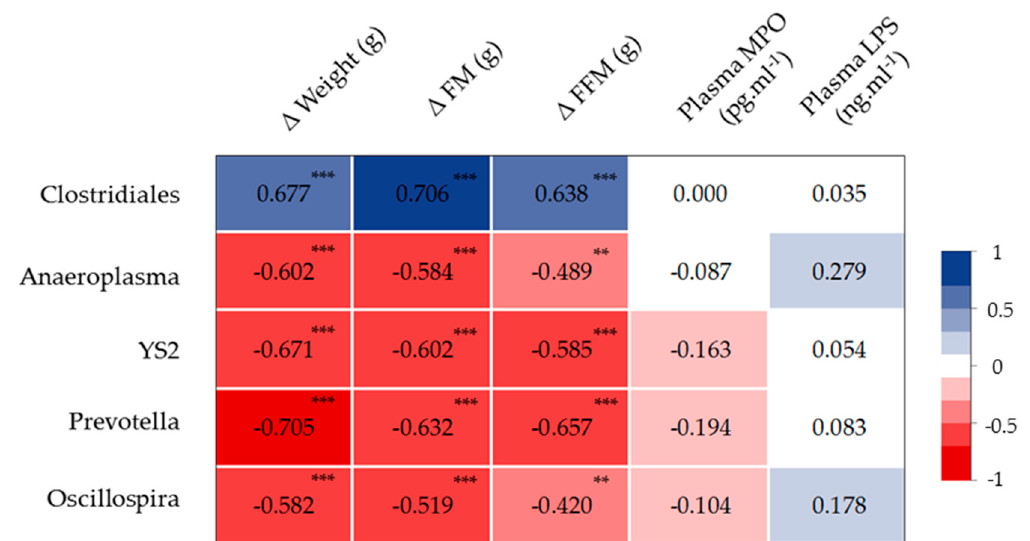
Figure 9. Heat map showing the association between the abundance of the indicated microbiota components, body composition, plasma myeloperoxidase (MPO), and LPS concentration. ** p < 0.01, *** p < 0.001. Δ FM and Δ FFM, changes in fat mass and fat-free mass between week 28 and week 16, respectively. Color scale indicates positive (blue) to negative (red) correlation.